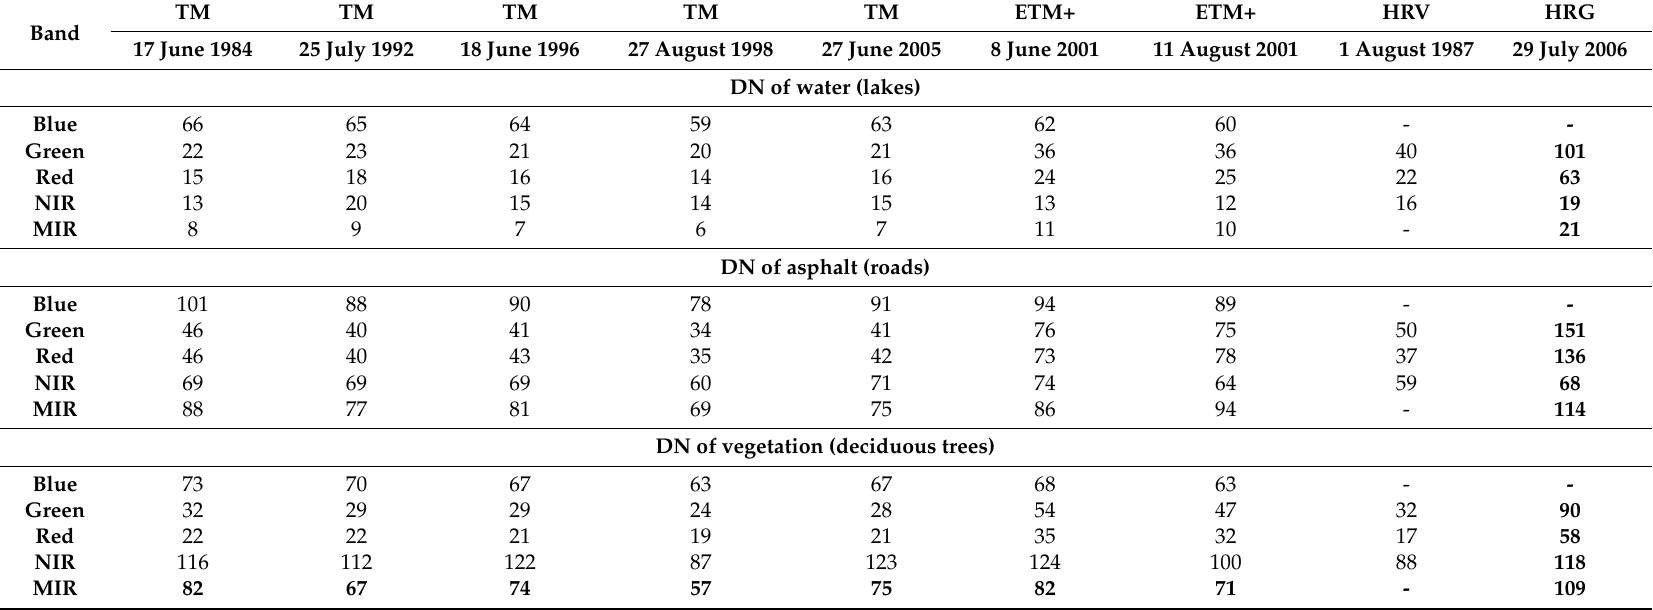
Table 5. Averages of DNs of the selected materials on Landsat and SPOT